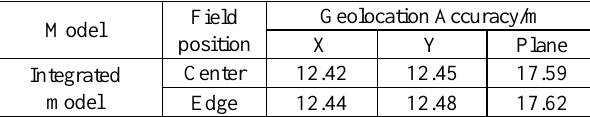
Table 3. Geolocation accuracy of integrated model Model